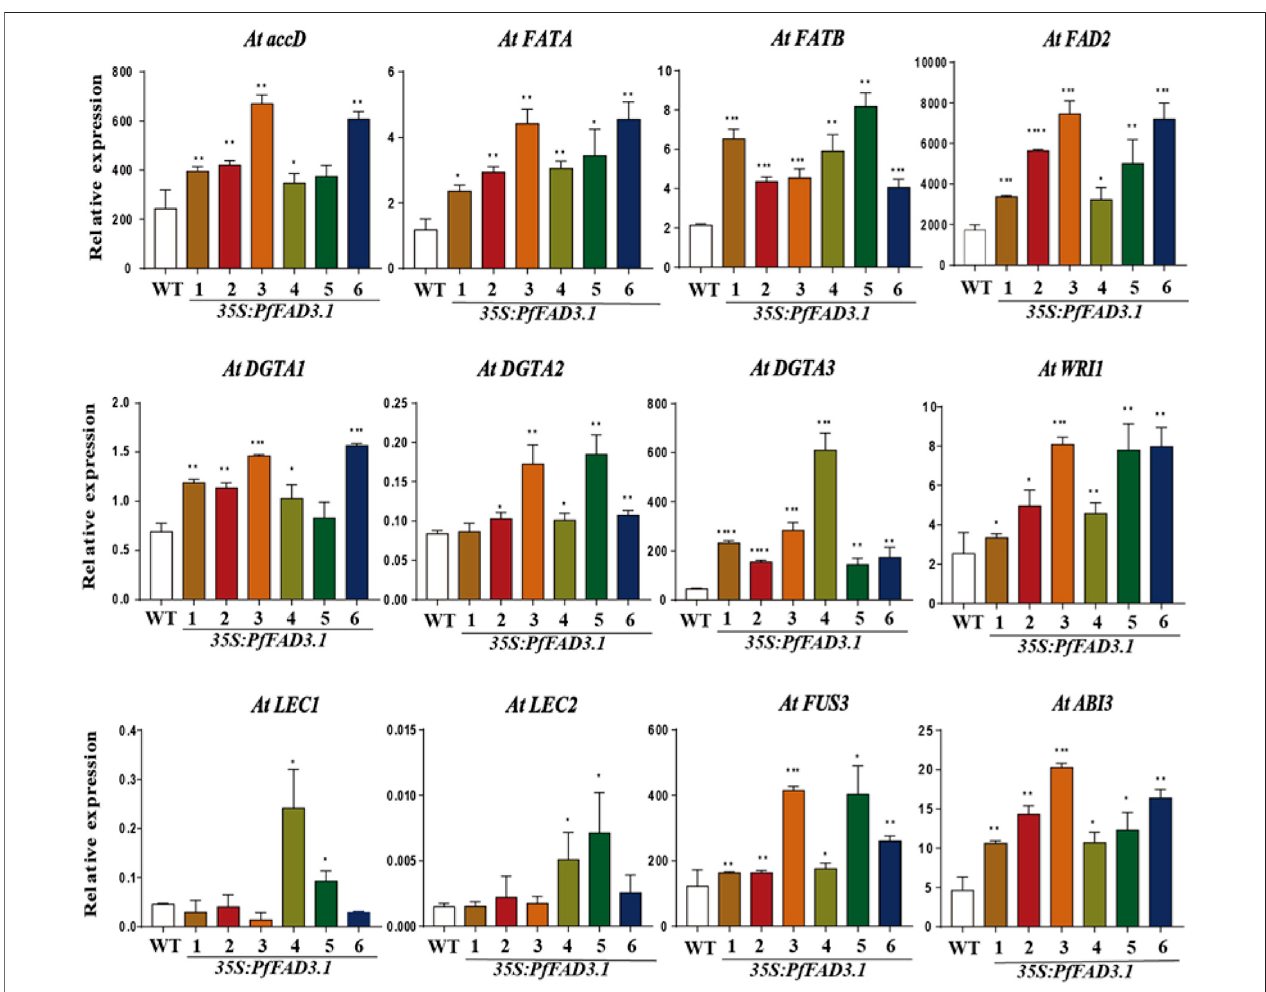
FIGURE 6 | The expression patterns of genes encoding key enzymes and transcription factors involved in α -linolenic acid biosynthesis in 35S:: PfFAD3.1 Arabidopsis seeds. Error bars represent SD from at least three biological replicates. The asterisks indicate signi fi cant differences (* p < 0.05, Student ’ s t-test).